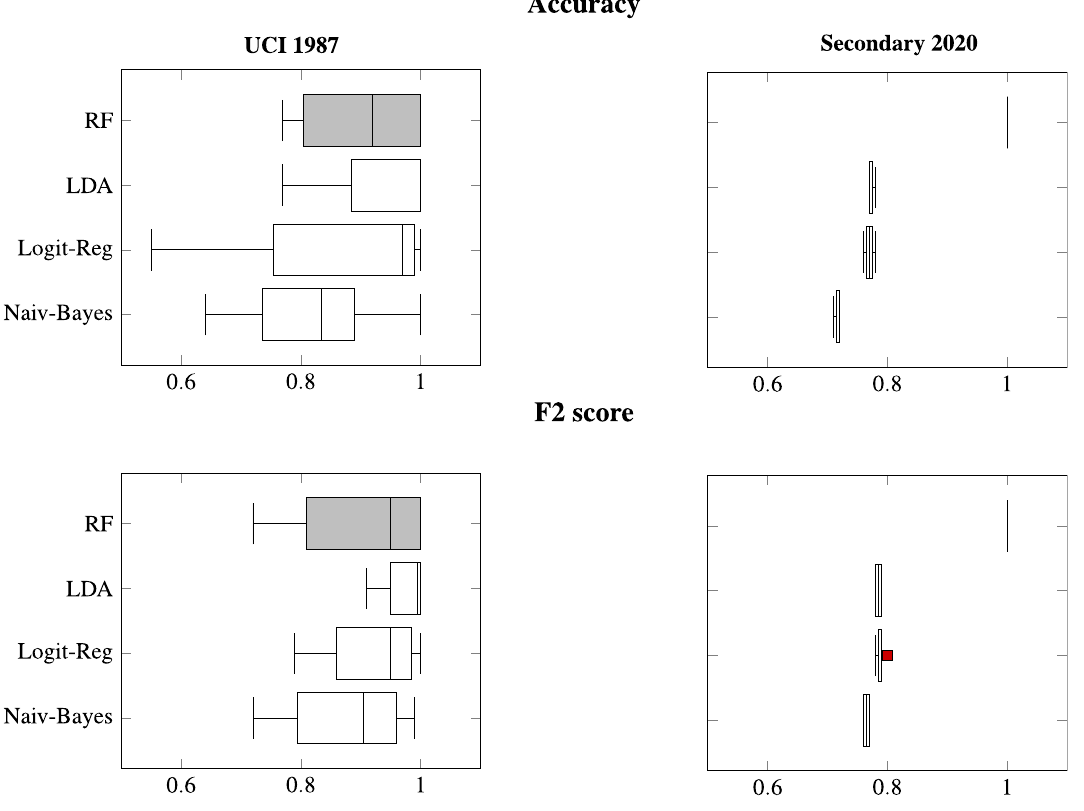
Figure 4. Five-fold cross-validation accuracy and F2 score results for both data sets and using each of the four classifiers. The highest score results are obtained using the RF classifier. They are reported in gray